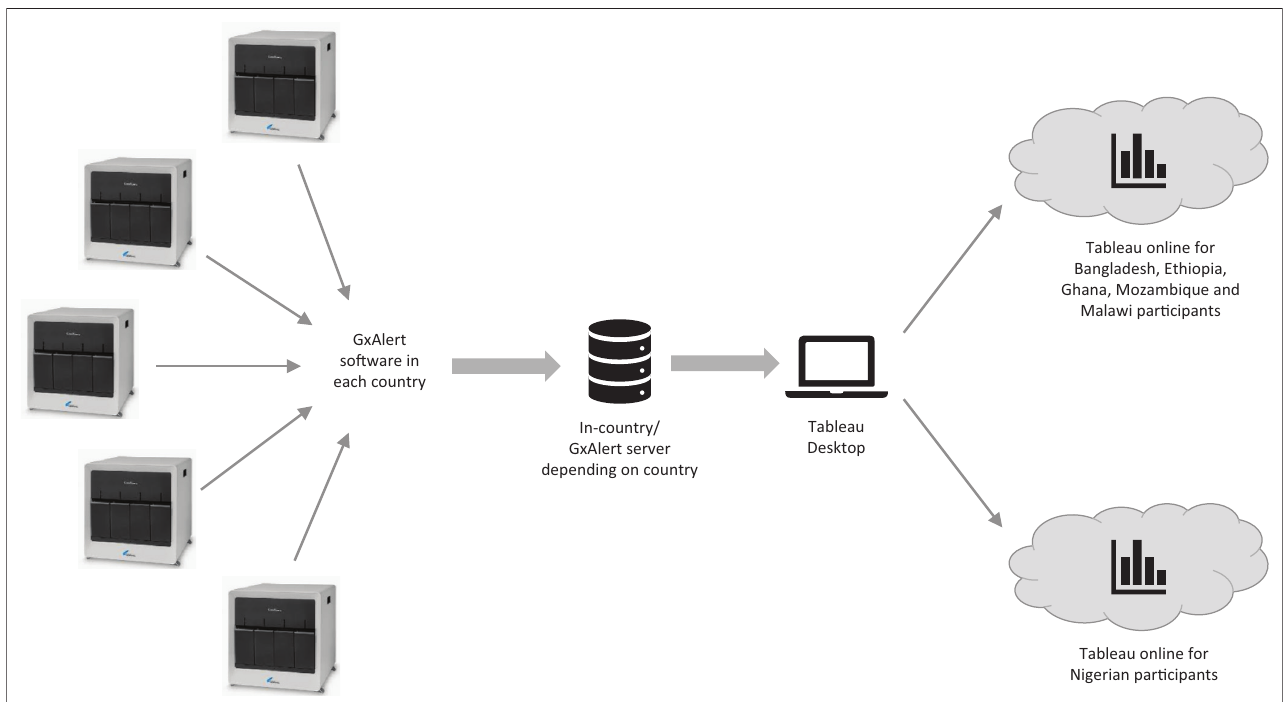
FIGURE 1: General informatics infrastructure and data flow for TB Data Fellowship programme. Live Xpert MTB/RIF data from each country is collected via GxAlert and stored on a in-country or private cloud hosted GxAlert server (depending on country preference). Each data fellow is able to download an extract of their own country data to Tableau Desktop in order to create various graph-like visualisations and basic analytics. Once analysis is complete, data fellows could choose to publish a subset of these visualisations, unlinked to the data source, via a community folder on Tableau Online, allowing them to share insights, ideas and graphics with other data fellows, the ministry of health or NTP.